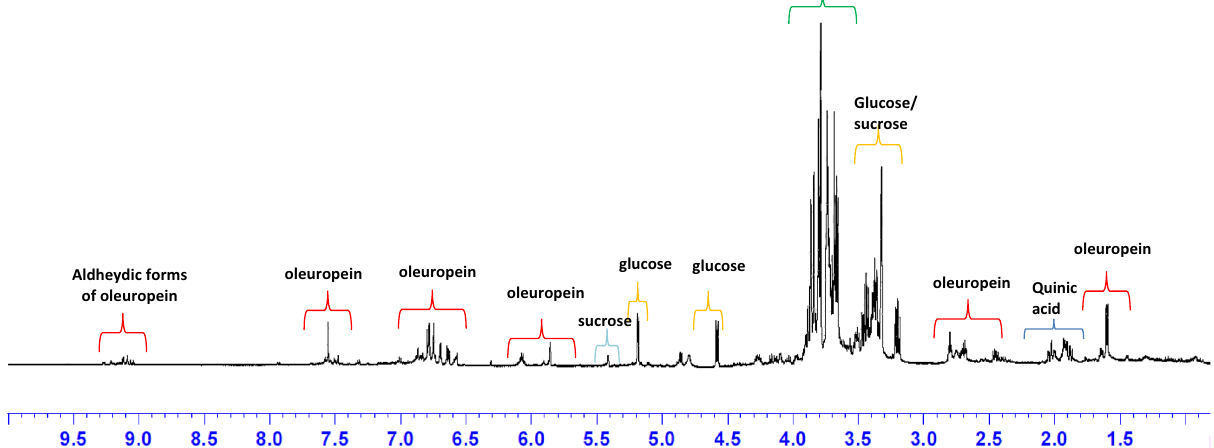
Figure 1. Typical aqueous 1 H NMR zgcppr spectrum of olive leaf extract. Main metabolites are